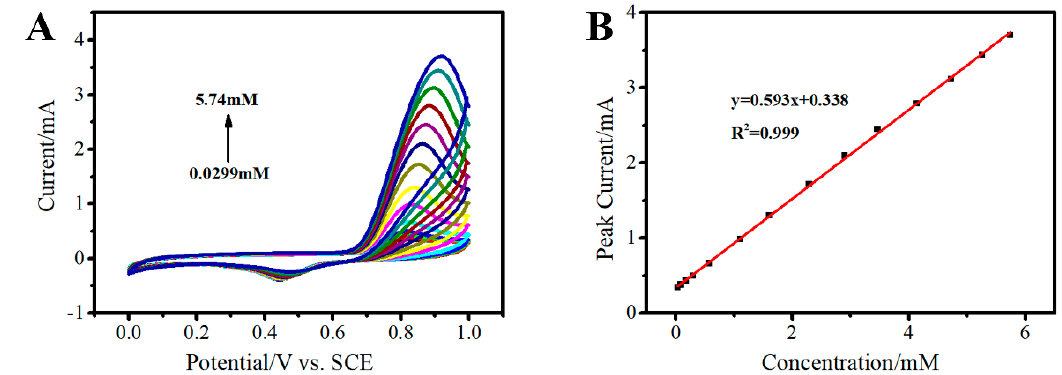
Figure 10. CVs of the 3D Au-rGO/FTO in PBS containing different concentrations of nitrite from 0.0299 to 5.74 mM ( A ); the relation between oxidation current versus the concentration of nitrite ( B ). Table 1. Comparison of different modified electrodes for nitrite determination.